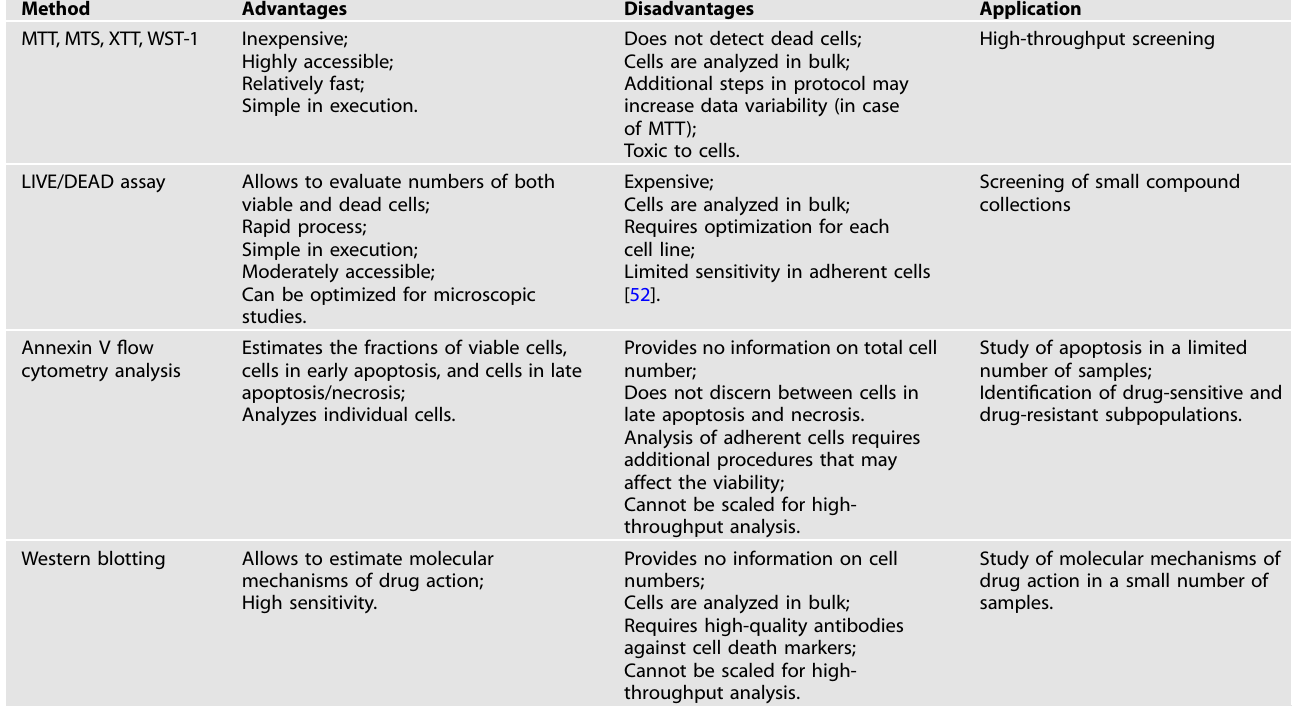
Table 1. Advantages and disadvantages of methods used for drug cytotoxicity